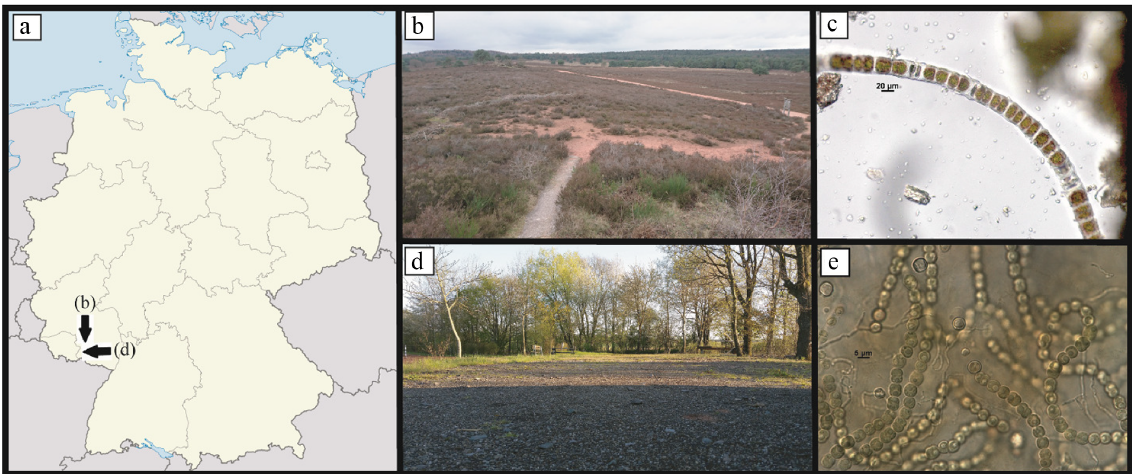
Figure 1. Organisms and map of the study site in Germany, Rhineland–Palatinate (a) : top pictures are from study site 1, Mehlinger heath viewed from the lookout (b) and microscopic images of the crust-dominating organism Zygogonium ericetorum (c) ; bottom depicts study site 2, a parking lot at an equestrian farm near Zweibrücken (d) and microscopic images of the crust-dominating organism Nostoc com- mune (e)